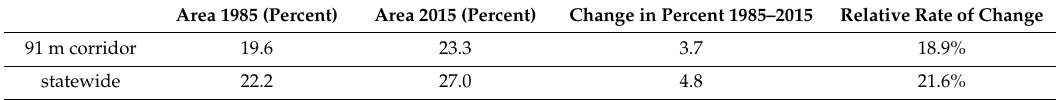
Figure 15. 2015 land cover distribution over prime and important agricultural soils (left) versus statewide (right). Table 2. Development footprint in riparian corridors versus